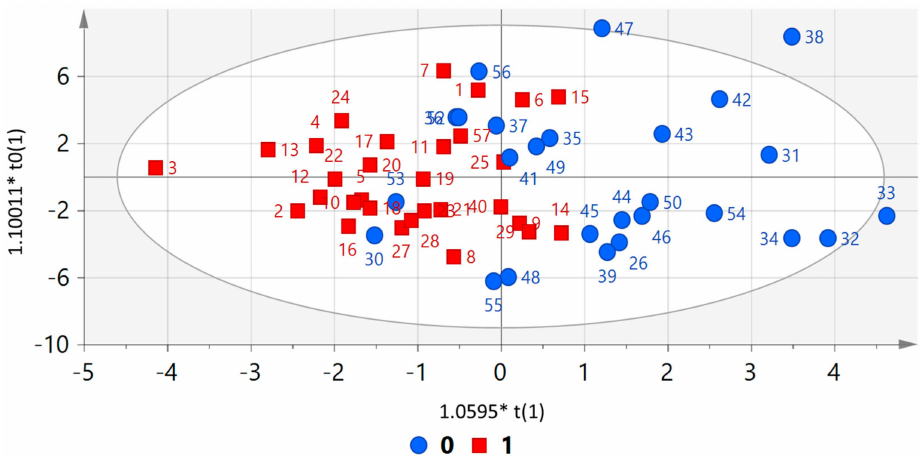
Figure 1. Score plot from orthogonal and partial least squares discriminant analysis (OPLS-DA) of case (1) and control (0) individuals. Input variables are metabolomic data. R 2 Y = 0.42, Q 2 = 0.16. unit variance scaling. Permutation R 2 = 0.217, Q 2 = − 0.333. cross-validated -ANOVA: 0.066.